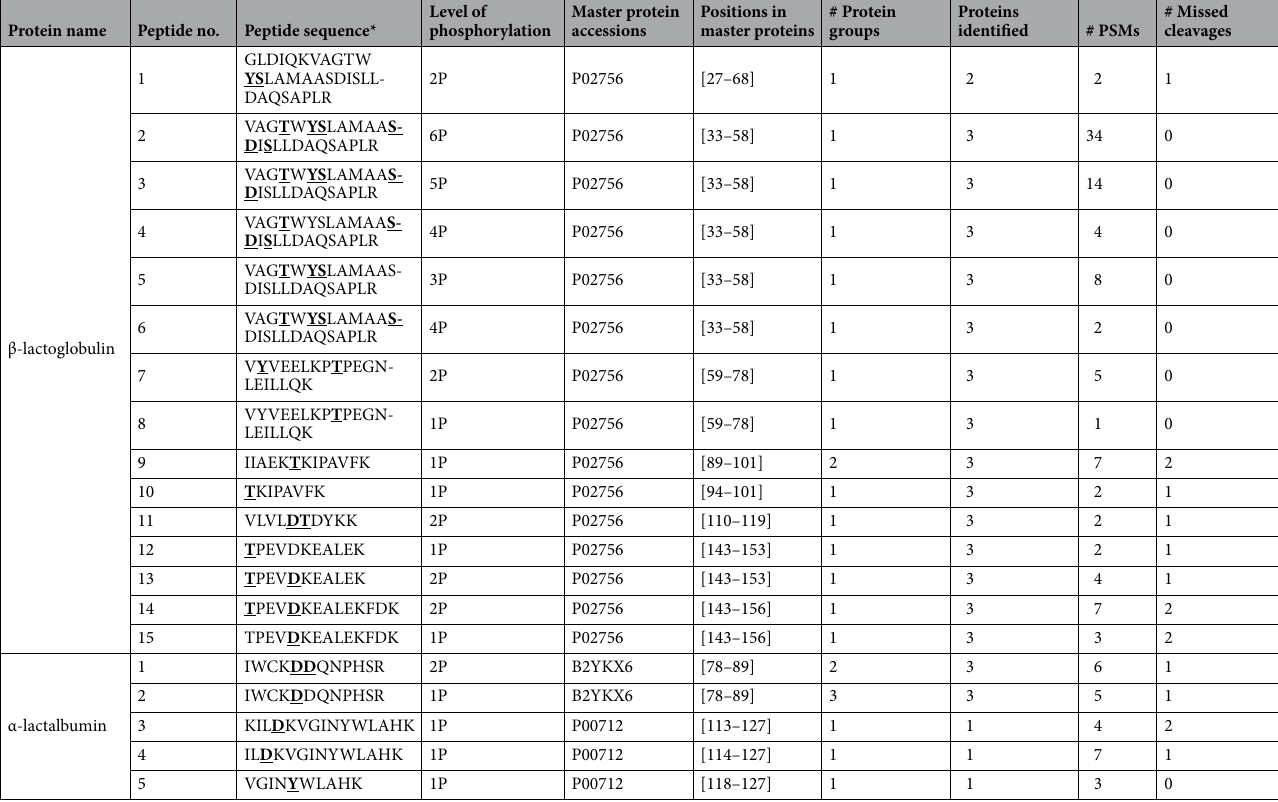
Table 2. Identification of phosphopeptides of caprine αS1, αS2, β, κ caseins and α-lactalbumin and β-lactoglobulin by nano-LC-MS/MS. * Phosphorylated amino acids are in bold and